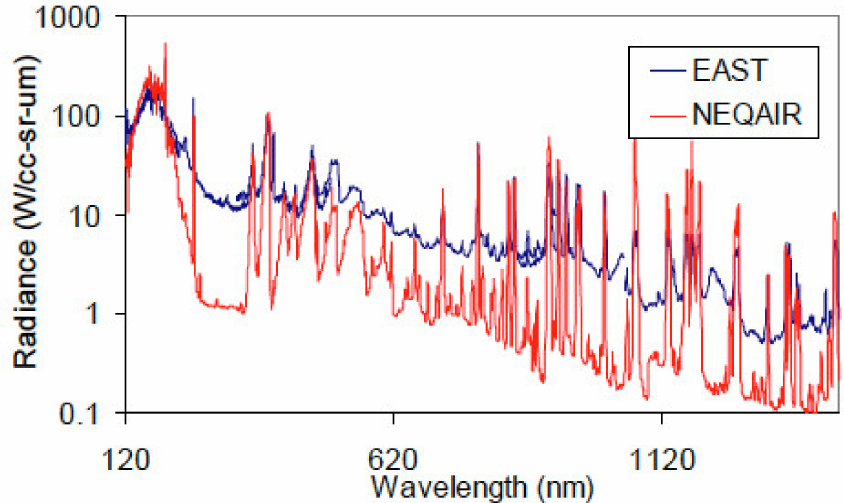
Figure 12. Comparison between EAST data and NEQAIR for Venus entry at 1 Torr and 9.5 km/s [17].